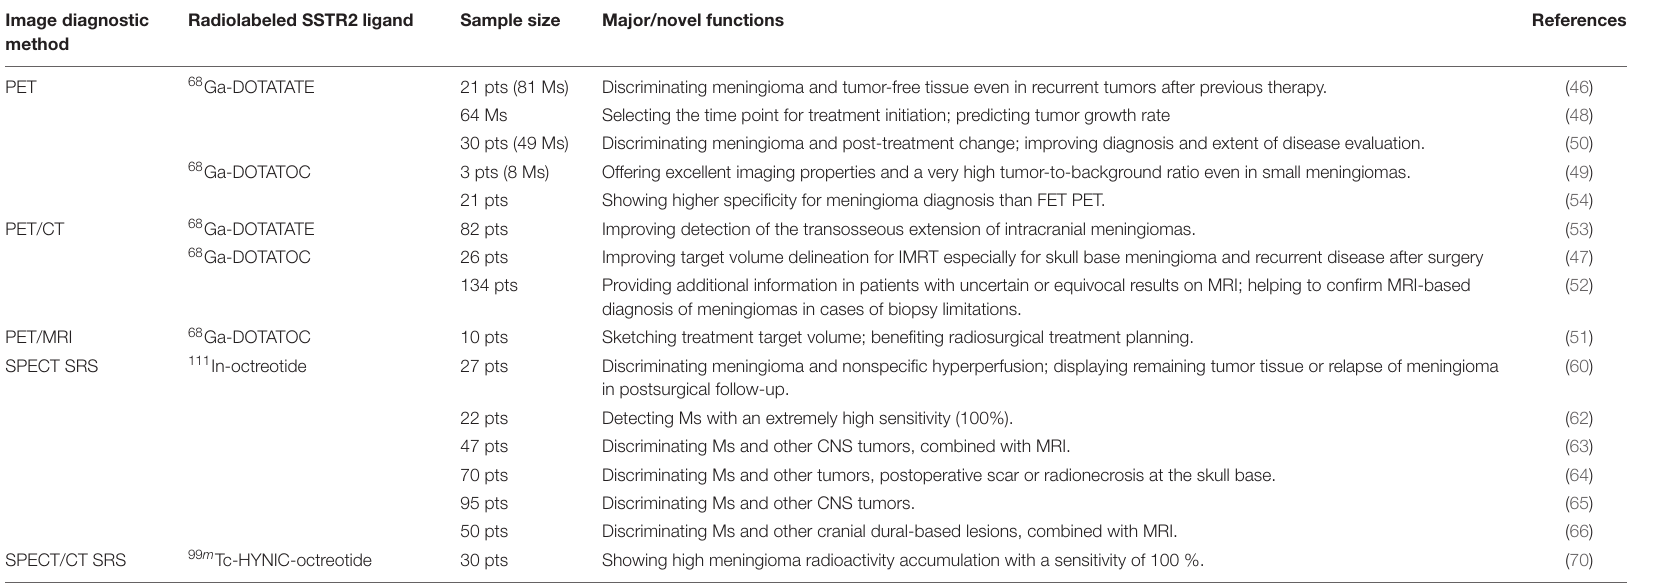
TABLE 2 | Clinical studies using radiolabeled SSTR2 ligands for meningioma diagnosis. Image diagnostic